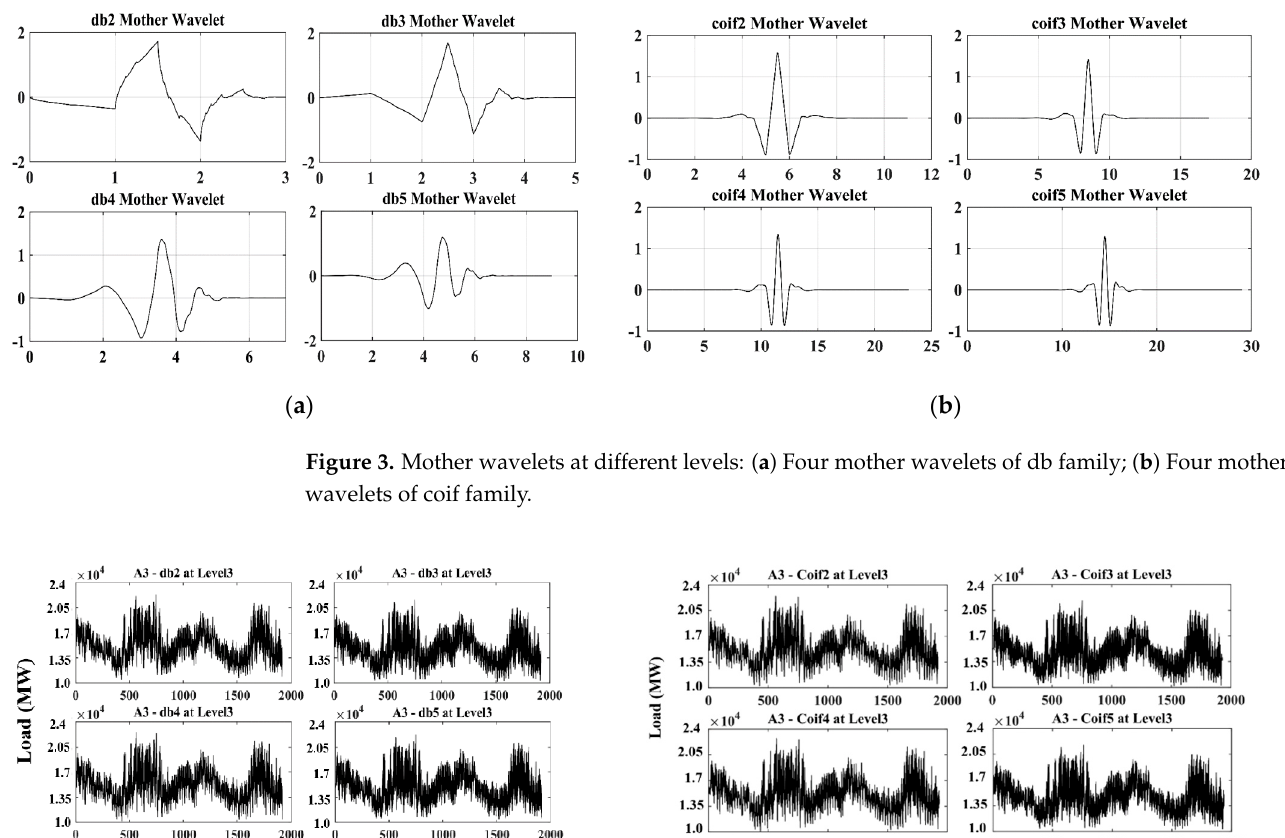
Figure 2. Proposed wavelet-based ensemble model: ( a ) Proposed wavelet diagram for Model 1 ,2, and 3; ( b ) Proposed wavelet diagram for model 4 (M4) .